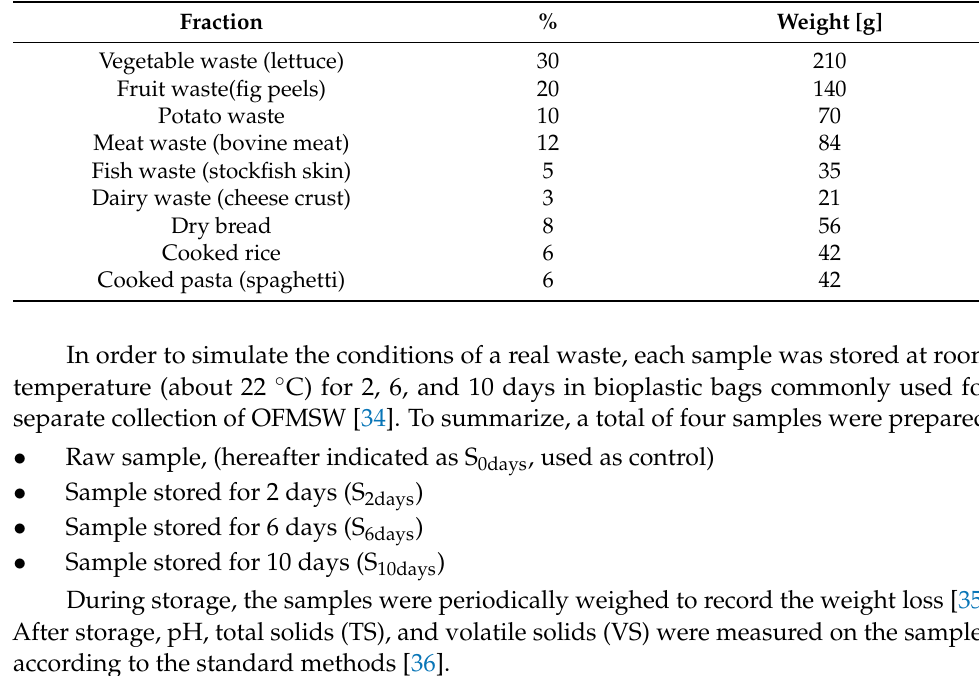
Table 1. Composition of synthetic OFMSW samples used in this